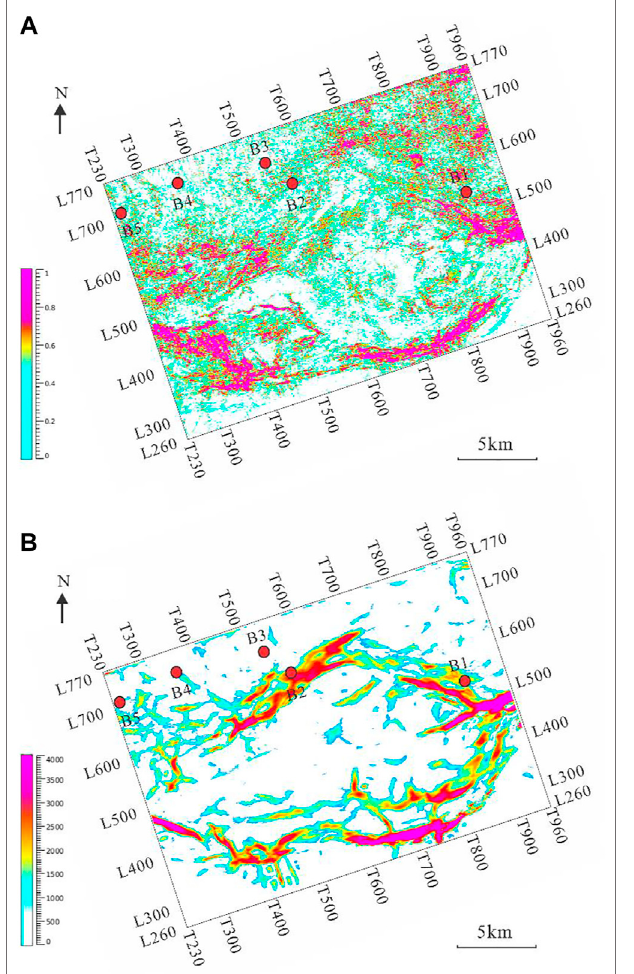
Frontiers in Earth Science |